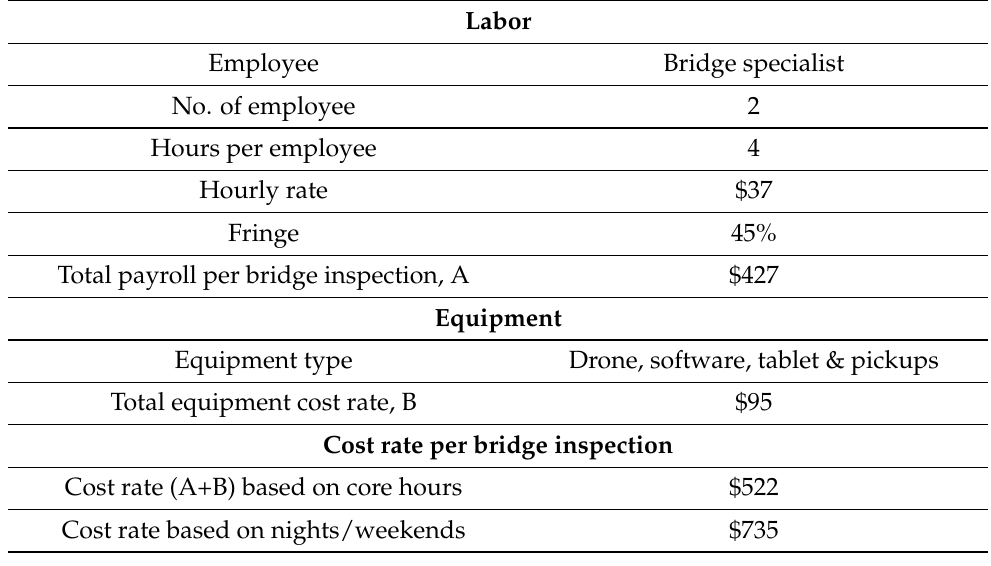
Table A2. Operational cost rate per bridge inspection using drone (source: